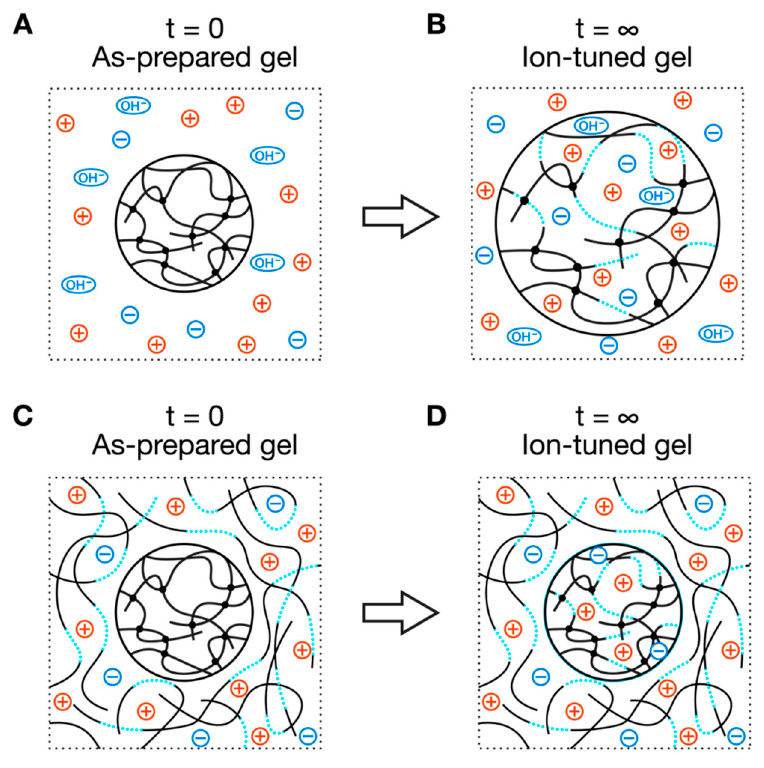
Figure 1. Scheme to prepare the polyelectrolyte gels with the same basic network structures but with different neutralization degrees and salt concentrations. ( A , B ) conventional scheme without linear ionizable polymer in the ion reservoir and ( C , D ) with linear ionizable polymer in the ion reservoir. The blue dotted curves and black solid curves denote charged polymer segments and noncharged polymer segments, respectively. Circles with red plus symbol and blue minus symbol represent mobile cations and anions, respectively.